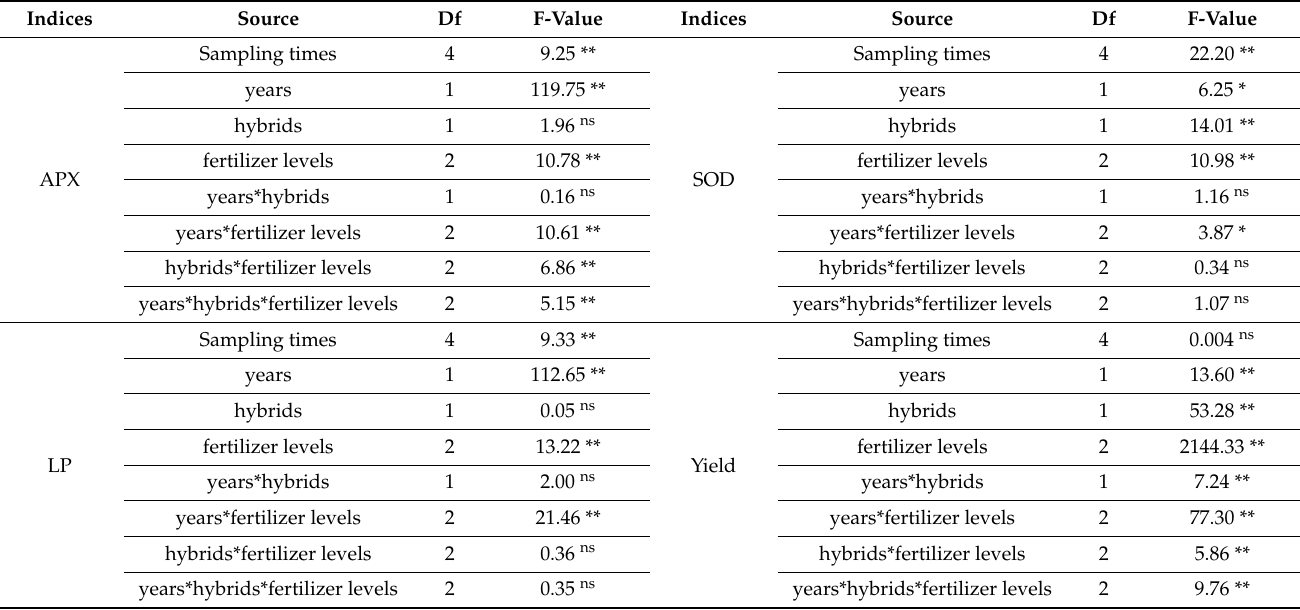
Table 6. Variance analysis based on NPK fertilizer.